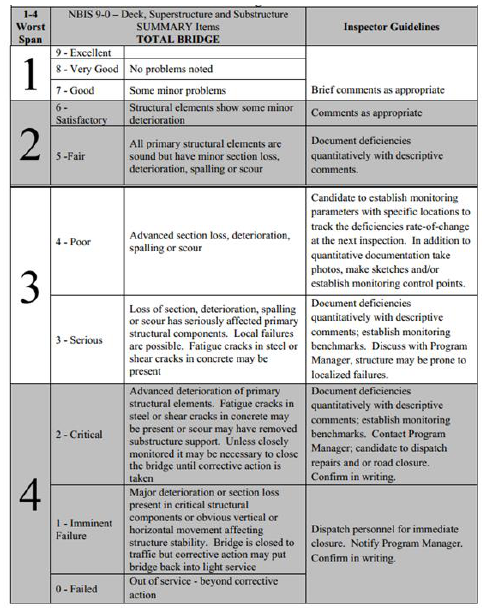
Table 1: Summary of condition rating guidelines for deck,